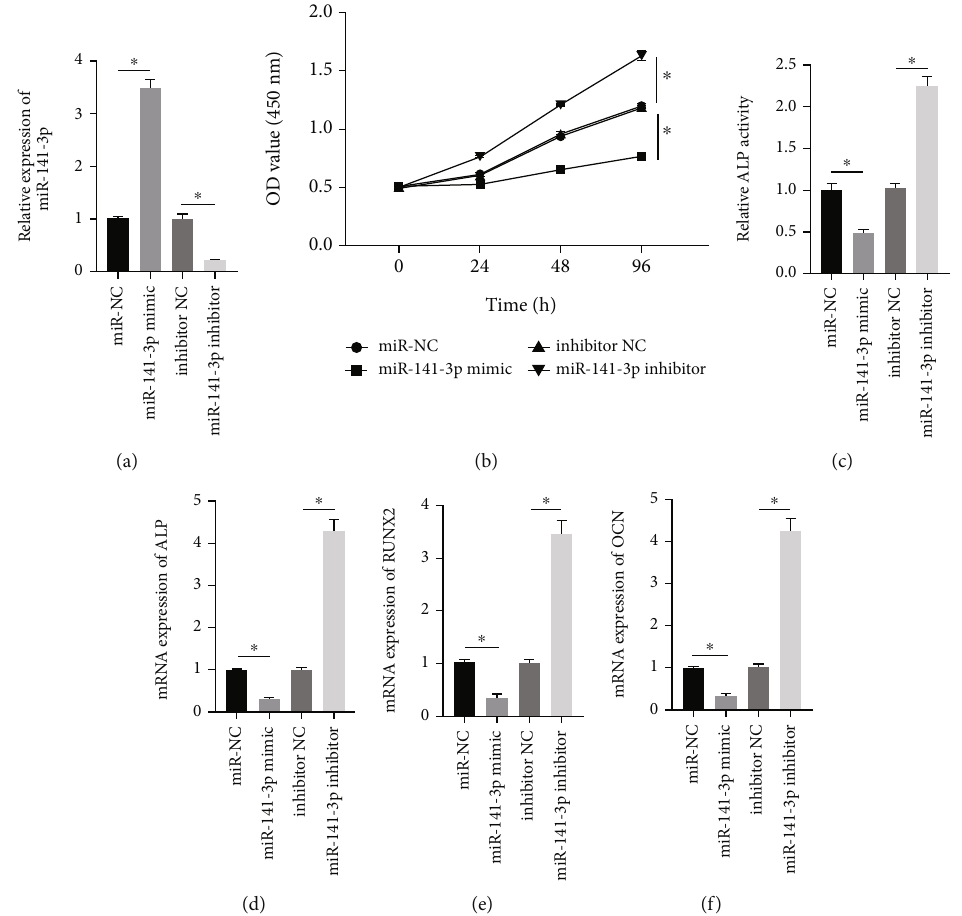
Figure 2: The miR-141-3p suppressed the osteogenic di ff erentiation ability of BMSCs. (a) The miR-141-3p expression was examined via RT-qPCR. (b) CCK-8 assay was applied to evaluate cell viability. (c) ALP activities were evaluated by spectrophotometry. (d) The mRNA expression of ALP, (e) RUNX2, and (f) OCN was examined via RT-qPCR.